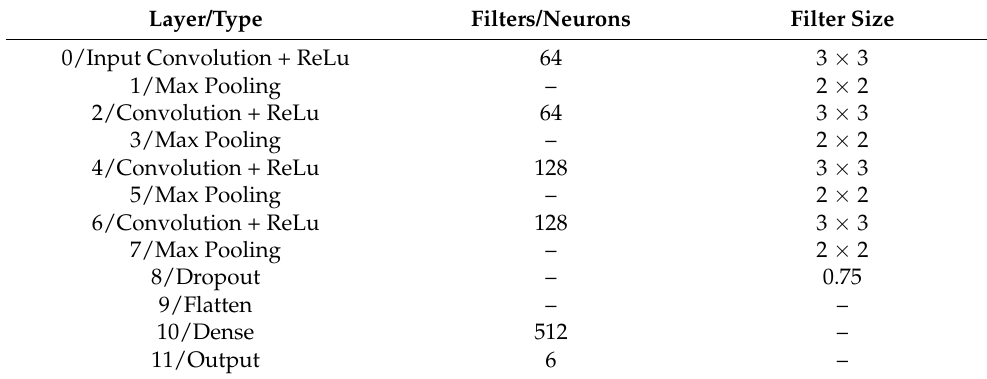
Table 5. Proposed